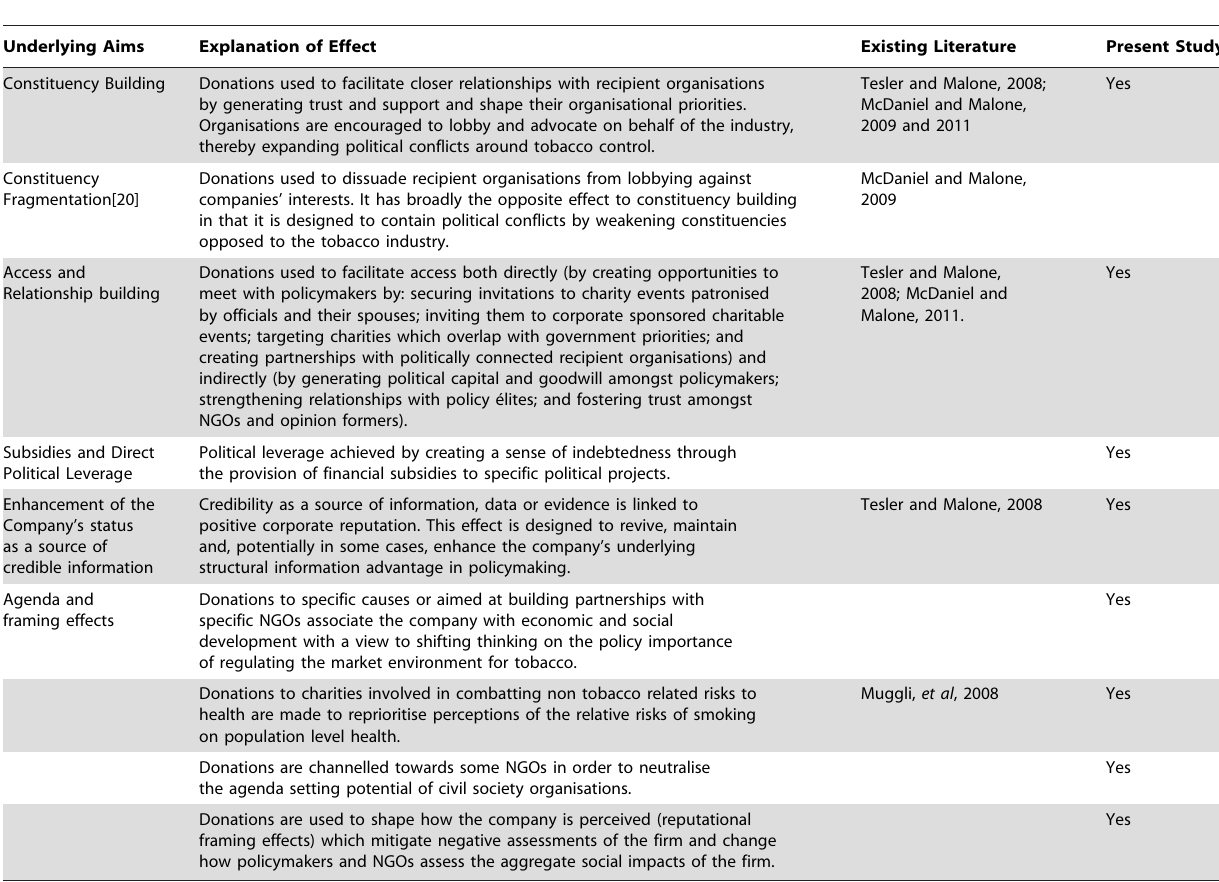
Table 2. Combined Political Aims underlying Tobacco Industry Philanthropy identified in the Present Study and Existing